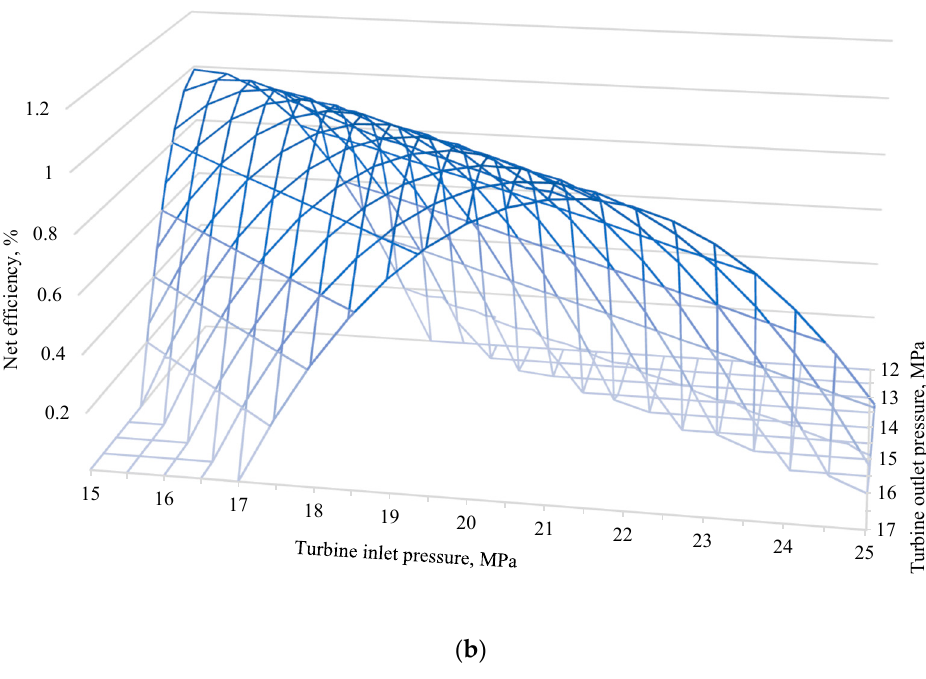
Figure 8. Simple Brayton air cycle efficiency dependence on turbine inlet and outlet pressure: ( a ) Turbine inlet temperature of 623 К ; ( b ) Turbine inlet temperature of 473 К . Based on the simulation results of power cycles with H 2 O, R124, R134a, R22, R41, R236ea and CO 2 , the net efficiency and dryness at the turbine outlet were determined with various combinations of initial parameters. At the turbine outlet, dryness below 86% of the input parameters combination was excluded from further analysis. For example, the water cycle reaches its maximal efficiency only with expansion into the humid steam area, therefore, it was necessary to remarkably limit the initial pressures (Figure 9). This is due to the high critical parameters combined with the wet-type working fluid [9], which differs from the other heat carriers. For organic coolants, the limitation of the initial pressure did not create significant restrictions.